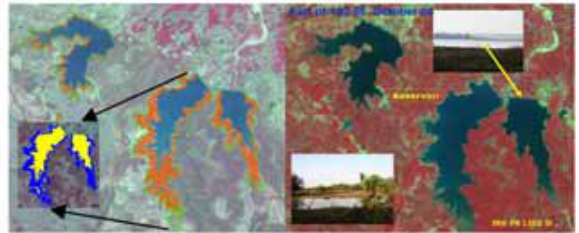
Figure 6. Aquatic Vegetation seen near Korba